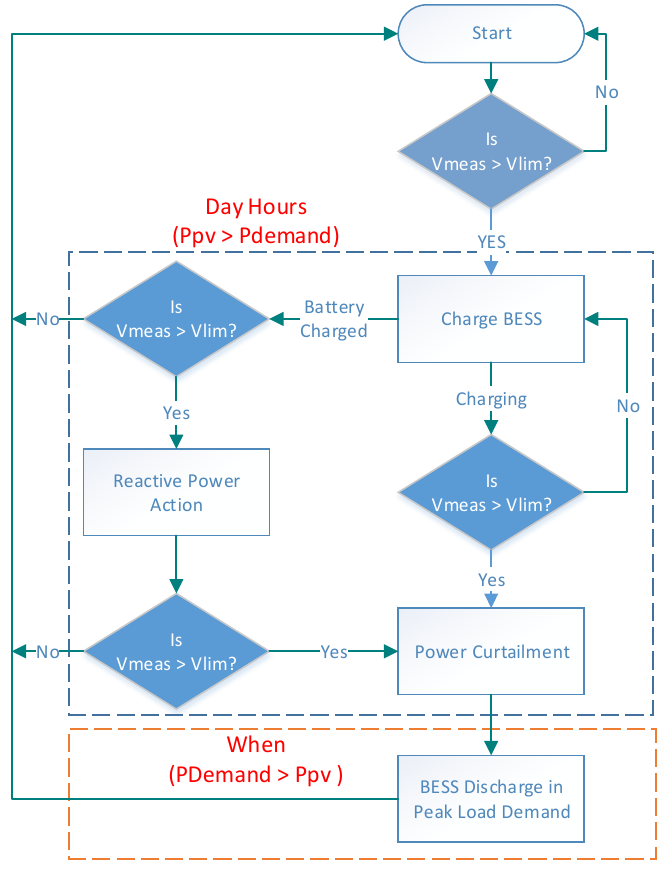
Figure 2. Flowchart for Distribution Control Algorithm.